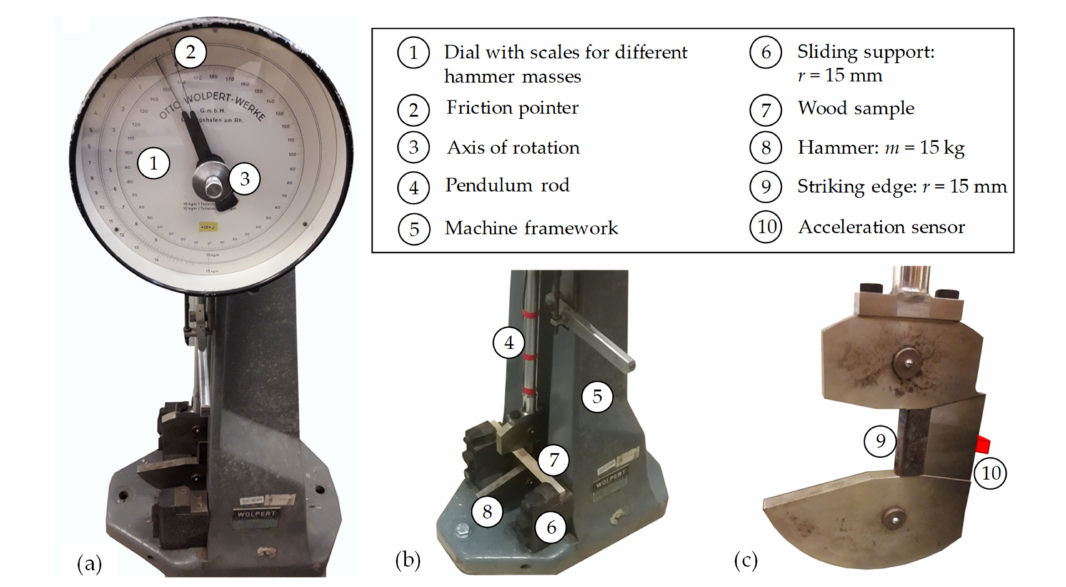
Figure 1. Overview of the impact pendulum testing device from the front ( a ), oblique view of the bottom part including a wood sample ( b ) and detailed view of the hammer head including an acceleration sensor on the back side ( c